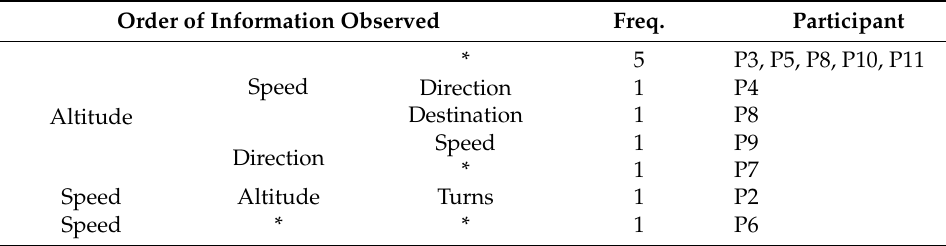
Table 8. Order of information observed for overtaking